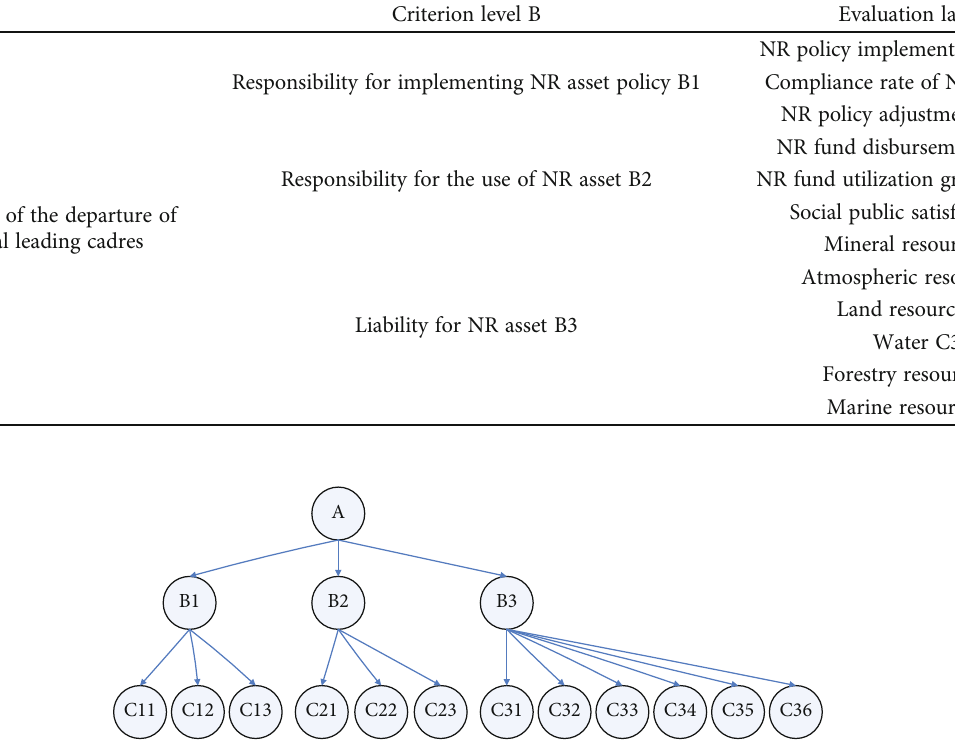
Figure 2: Hierarchical model diagram.